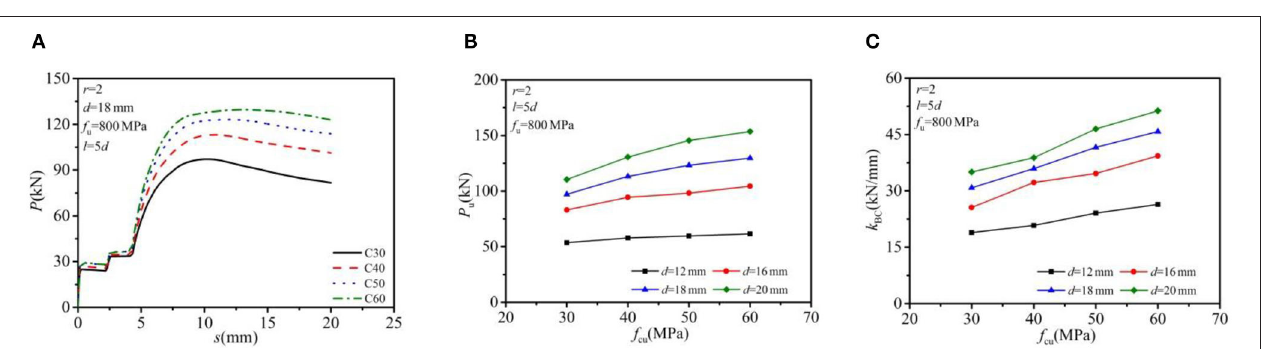
FIGURE 11 | Effect of concrete strength: (A) load–slip curve; (B) shear-bearing capacity; and (C) shear stiffness.